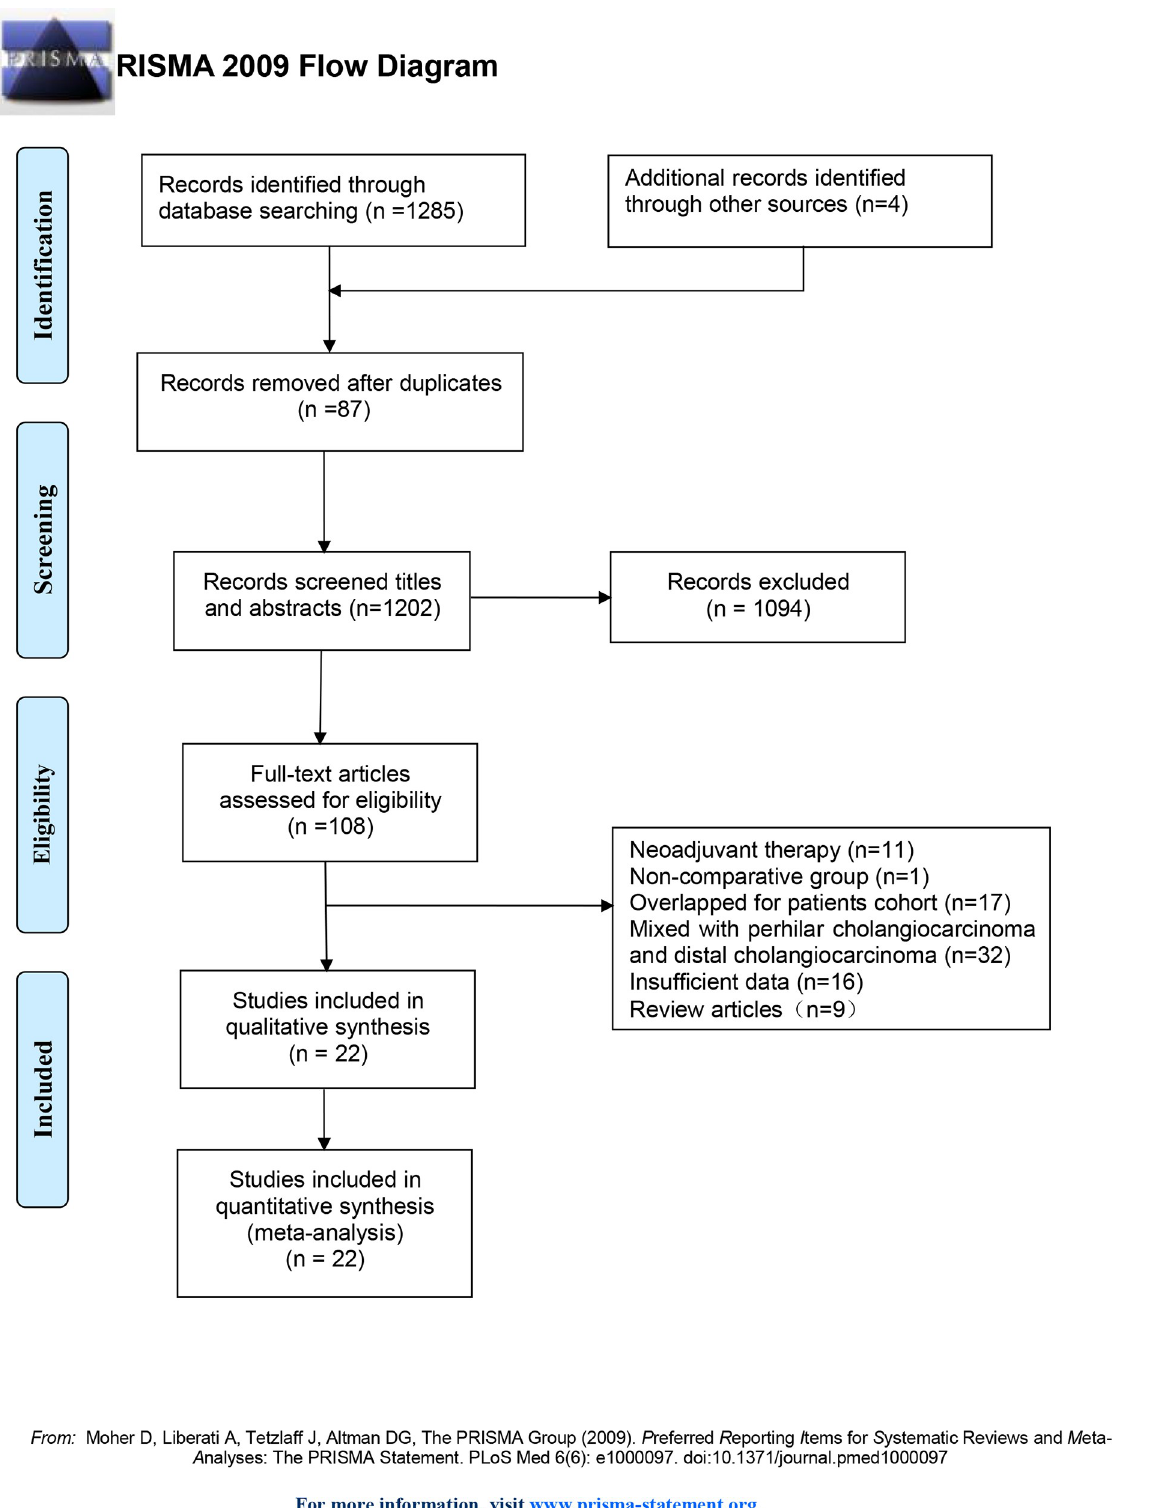
Fig 1. PRISMA flow diagram showing selection of articles for meta-analysis.